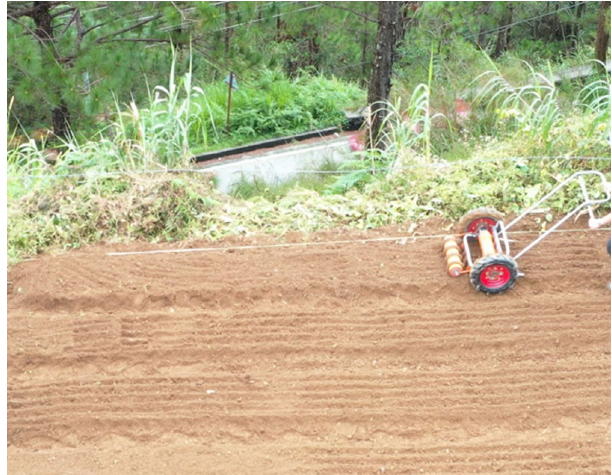
Figure 8. Field testing of the carrot seeder administered by the Agricultural Machinery and Testing Evaluation Center, University of the Philippines Los Baños